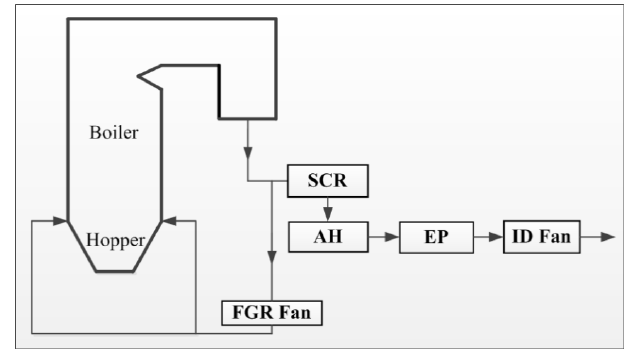
Figure 9. Extract points in the system of double-reheat boiler.